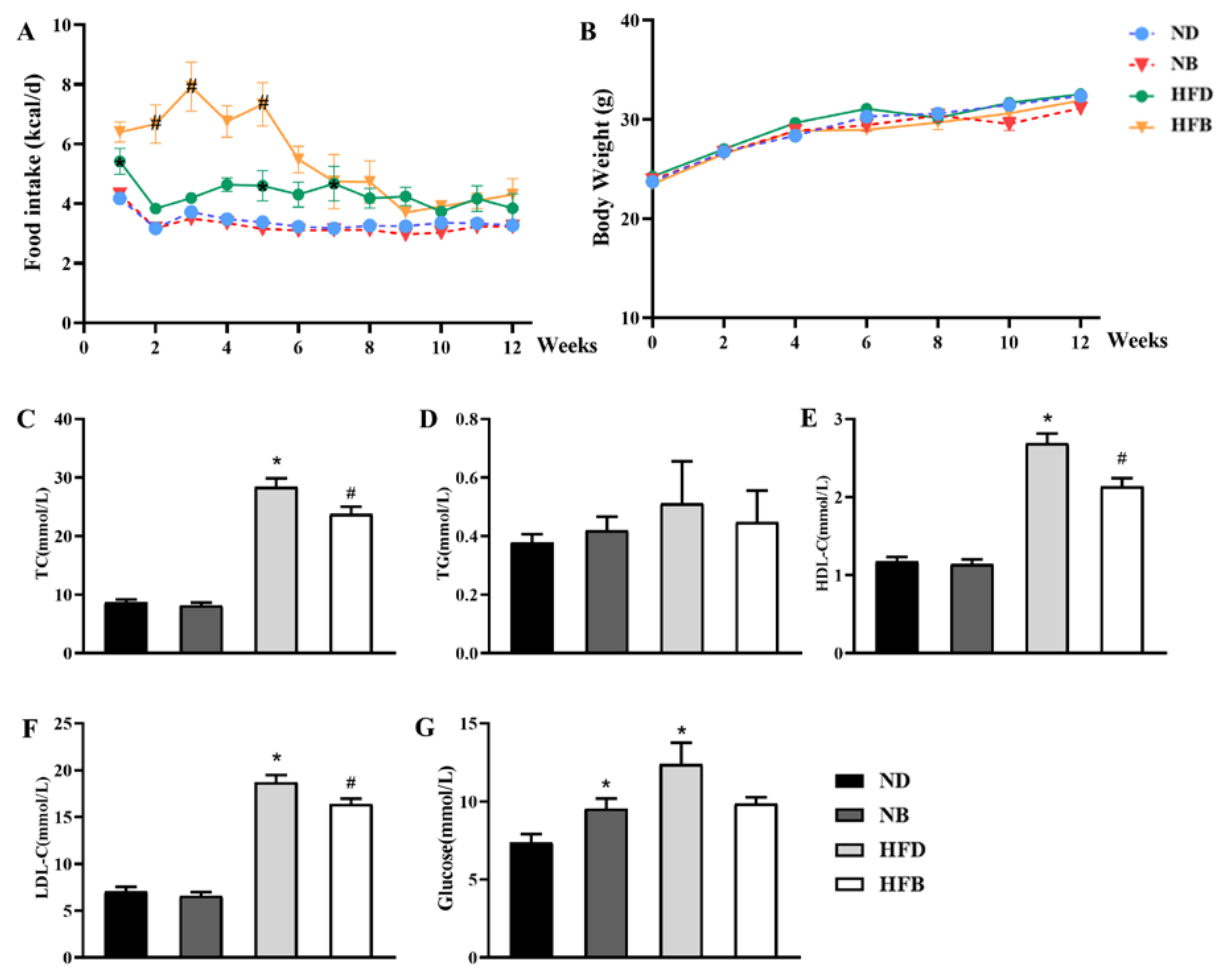
Figure 2. BCAA supplementation ameliorates dyslipidemia induced by a high-fat diet in ApoE −/− mice. ( A , B ) The food intake ( A ) and body weight growth curve ( B ) of ApoE −/− mice (0–12 weeks). The data were analyzed by two-way ANOVA. ( C – G ) Serum concentrations of ( C ) TC, ( D ) TG, ( E ) HDL-C, ( F ) LDL-C, and ( G ) glucose. The data are expressed as the mean ± SEM ( n = 8 for each group). * p < 0.05 vs. ND group; # p < 0.05 vs. HFD group.